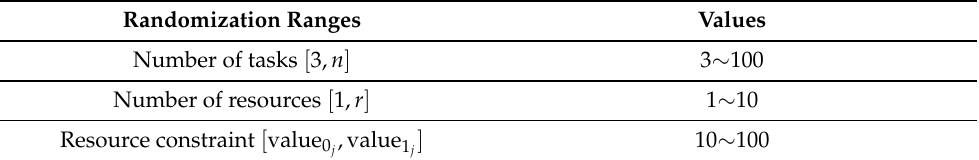
Table 5. Randomization ranges to generate the set of tasks to be scheduled.